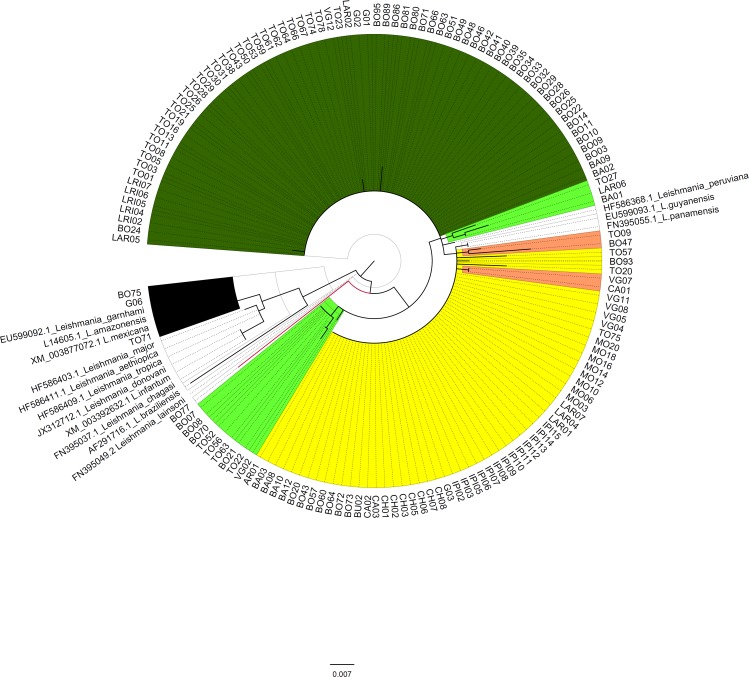
Phylogenetic reconstruction of HSP70 sequences.Phylogenetic reconstruction of 150 HSP70 gene sequences obtained from direct samples of CL patients and the reference strain retrieved from GenBank. L. braziliensis (green); L. panamensis (yellow); L. mexicana (black) and L. lainsoni (red). Futhermore, different genotypes associated with L. braziliensis (light green) and L. panamensis (light pink) were identified. The numbers represent the coding of each sample.